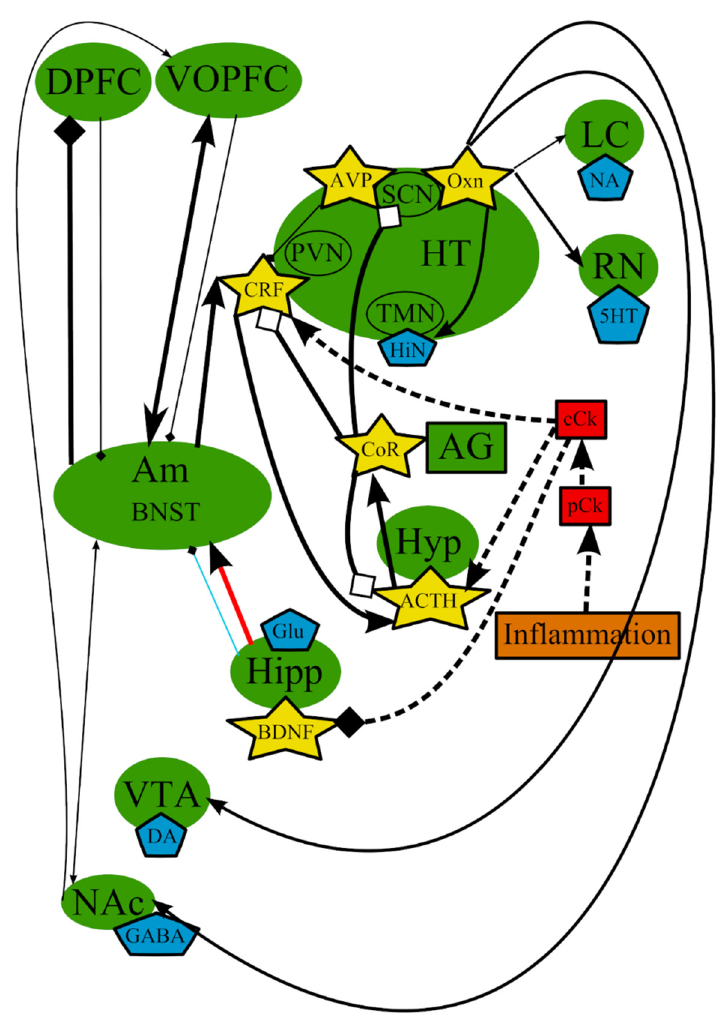
Figure 3. The inflammation/cytokine hypothesis: main structures, neurotransmitters, biologically active substances, interactions, and external factors. ACTH—adrenocorticotropic hormone; AG— adrenal gland; Am—amygdala; AVP—arginine-vasopressin; BDNF—brain-derived neurotrophic factor; BNST—bed nuclei stria terminalis; cCk—central pro-inflammatory cytokines; CoR—corti- sol; CRF—corticotropin-releasing factor; DA—dopamine; DPFC—dorsal prefrontal cortex; Glu— glutamine; GABA—gamma-aminobutyric acid; HiN—histamine; Hipp—hippocampus; HT—hy- pothalamus; 5-HT—serotonin; Hyp—hypophysis; LC—locus ceruleus; NA—noradrenaline; NAc—nucleus accumbens; Oxn—orexin; SCN—suprachiasmatic nucleus; TMN—tuberomammi- lar nucleus; RN—raphe nucleus; pCk—peripheral pro-inflammatory cytokines; PVN—para- ventricular nucleus; VOPFC—ventral and orbital prefrontal cortex; VTA—ventral tegmental area; -> (arrow): activating effect; -<> (rhombus): a black rhombus—inhibitory effect; a white rhombus: an effect is blocked or ineffective because the receptor is not sensitive; thick line—effect is in- creased; thin line—effect is decreased; medium thickness line—effect is not changed or alterations of the effect are unknown; red line—noradrenaline effect (most of them were omitted to simplify the figure); blue line—serotonin effect (most of them were omitted to simplify the figure); black line—various neurotransmitters or neuropeptides; dotted lines—influence of external factors. A connection of MDD with other pathologies, such as arthritis, asthma, coronary ar- tery disease, diabetes, and obesity, may indicate that inflammation by itself or in conjunc- tion with stress may cause MDD [39]. Depression associated with inflammation is charac- terized by greater persistence and severity and decreased motivation, and it develops later in life [164–166].